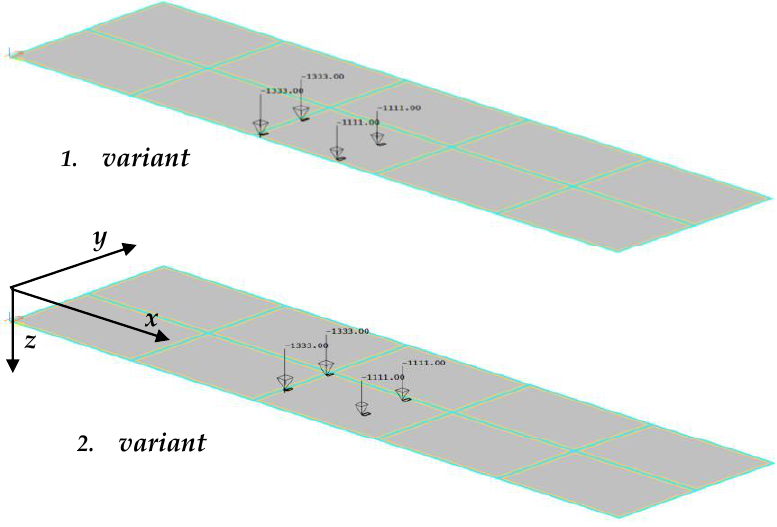
Figure 14. Variations in load position used for the numerical study.